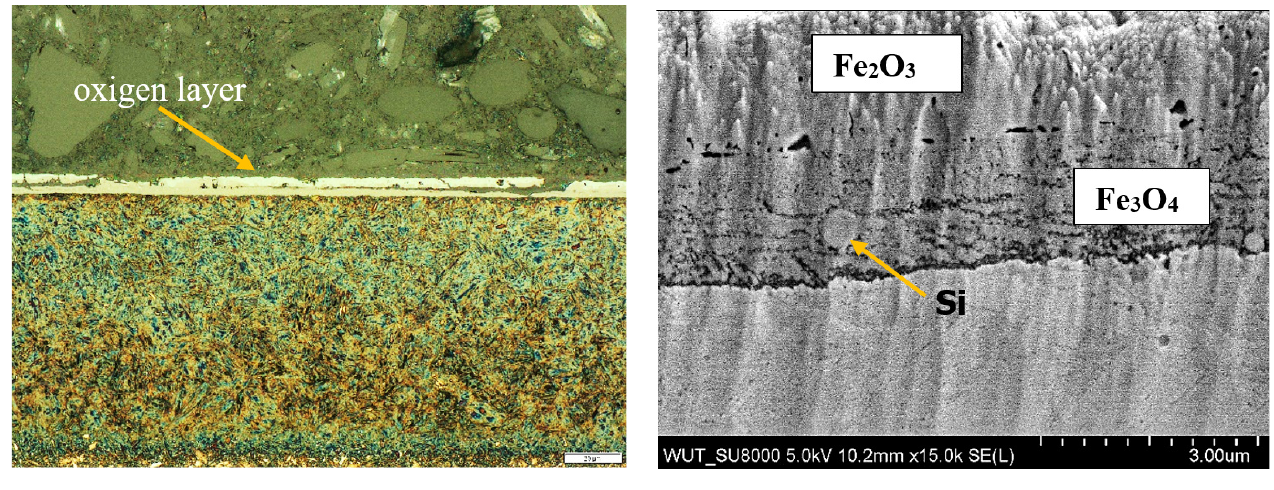
Figure 7. Two-zone oxide layer on the surface of the v1 sample (12 h annealing).( a ) microstructure of steel with oxide layer indicated by arrow, magnification 2500×; ( b ) enlarged fragment of the oxide layer, the upper zone of the layer contains Fe 2 O 3 , the lower zone contains Fe 3 O 4 , silicon precipitation was identified in the lower zone of the oxide layer.